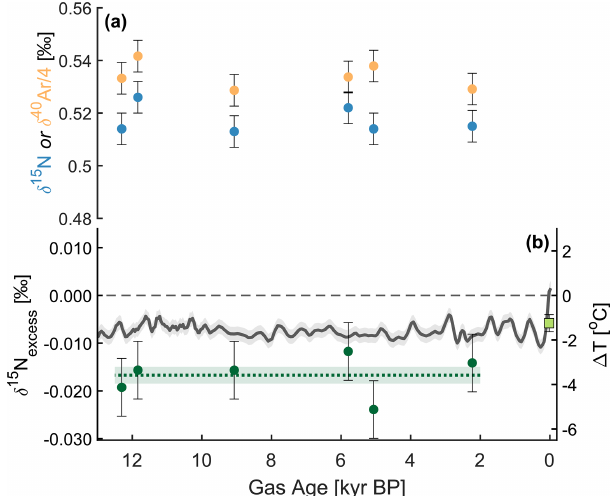
Figure 9. Measurements of (a) δ 15 N and δ 40 Ar used to calculate (b) δ 15 N excess and an estimate of (cid:49)T z from the Dome Fuji ice core. The (cid:49)T z data are plotted as dark green circles and compared to a model estimate of past (cid:49)T z at Dome Fuji from Buizert et al. (2021) (grey line and shading). The dashed green line shows the mean of the data, and the shading represents 1 standard error of the mean of the six samples. The light green point shows an estimate of mod- ern (cid:49)T z at Dome Fuji calculated using the method described in Sect. S3.2. The estimate is based on a new firn air dataset from archived samples collected in 1998 (Kawamura et al., 2006) and re-measured at SIO in